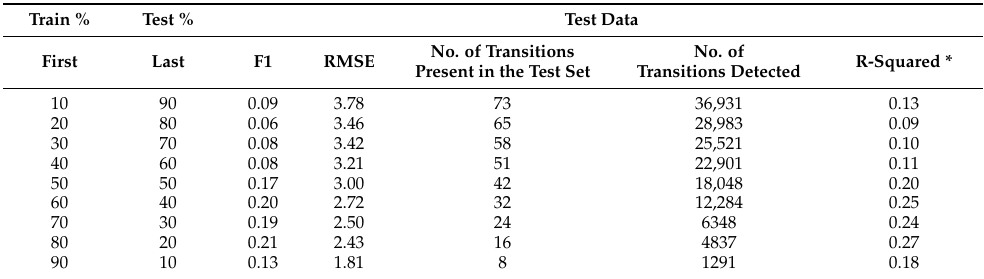
Table 4. Forecasting efficacy of the logistic regression model for different training and testing partitions. Train % Test %